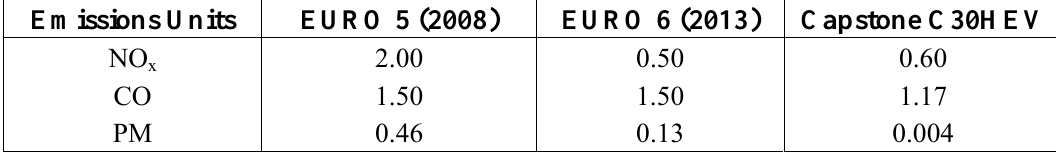
Table 21. Capstone C30HEV (diesel) emissions [8] at full load (g/kWh).